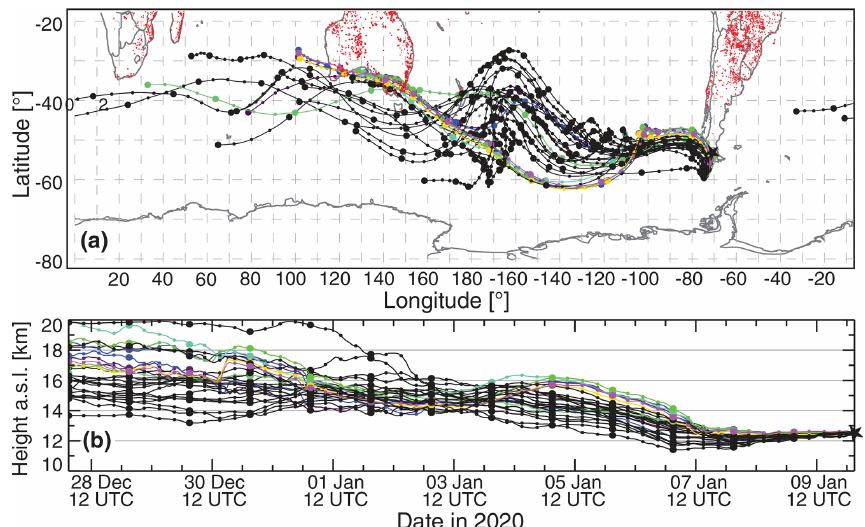
Figure 2. The 13-d backward trajectories (HYSPLIT, 2020) arriving at Punta Arenas (black star) on 10 January 2020, 03:00UTC at 12.5km height a.s.l. The colored backward trajectories crossed the bushfire and pyro-Cb areas in southeastern Australia and downwind over the adjacent Pacific Ocean on 30–31 December 2020. Fires occurring between 21 and 30 December 2019 are given as red dots (in a ) and provided by FIRMS